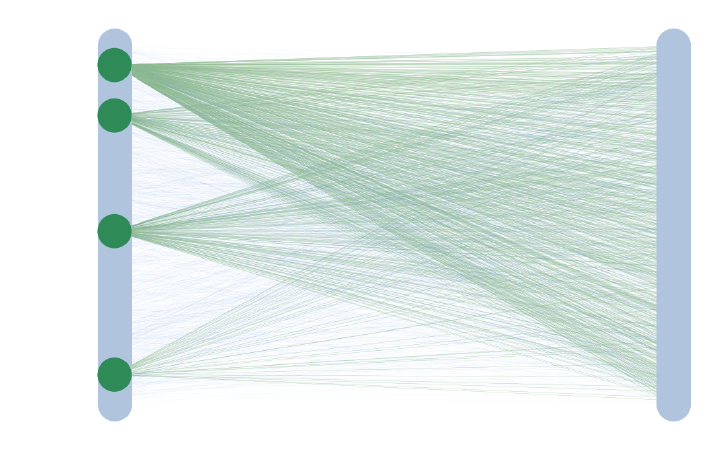
Figure 2. Bipartite Language Graph with Participant Nodes/Edges Highlighted. Left Side: Nodes in B that were also nodes in the original hypergraph H ; Right Side: Nodes in B that were edges in the original hypergraph H